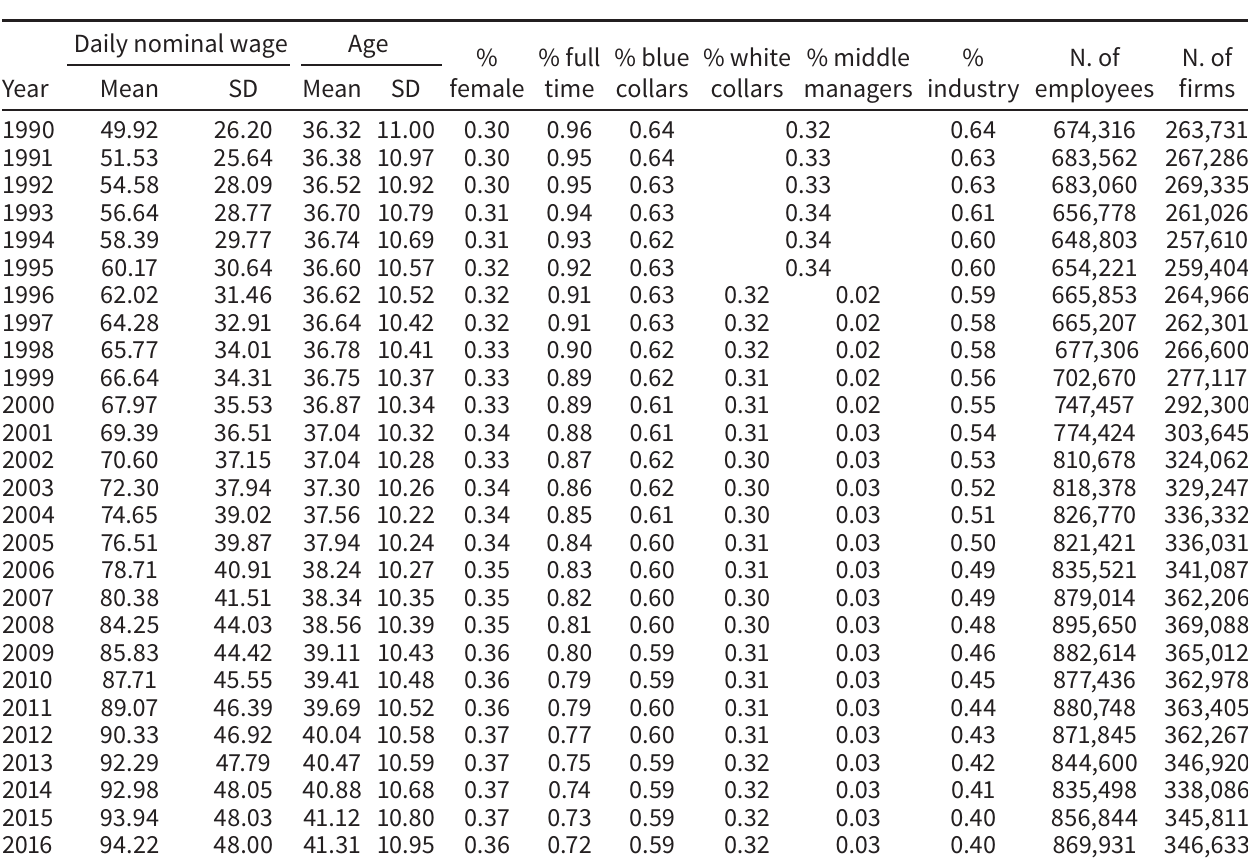
Descriptive statistics on workers (at the contract level)